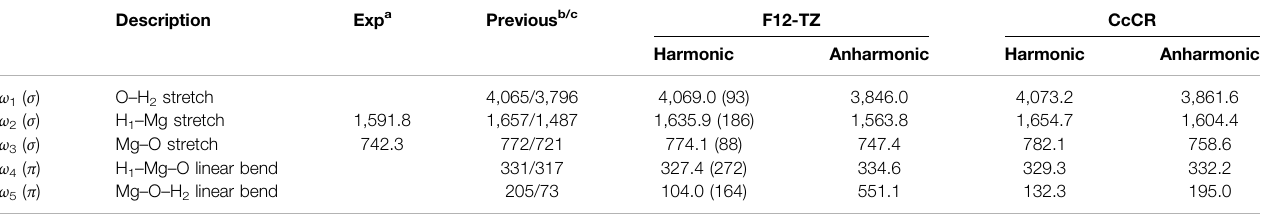
TABLE 5 | Vibrational frequencies (in cm − 1 ) of HMgOH with MP2/aug-cc-pVTZ intensities in parentheses (in km/mol).